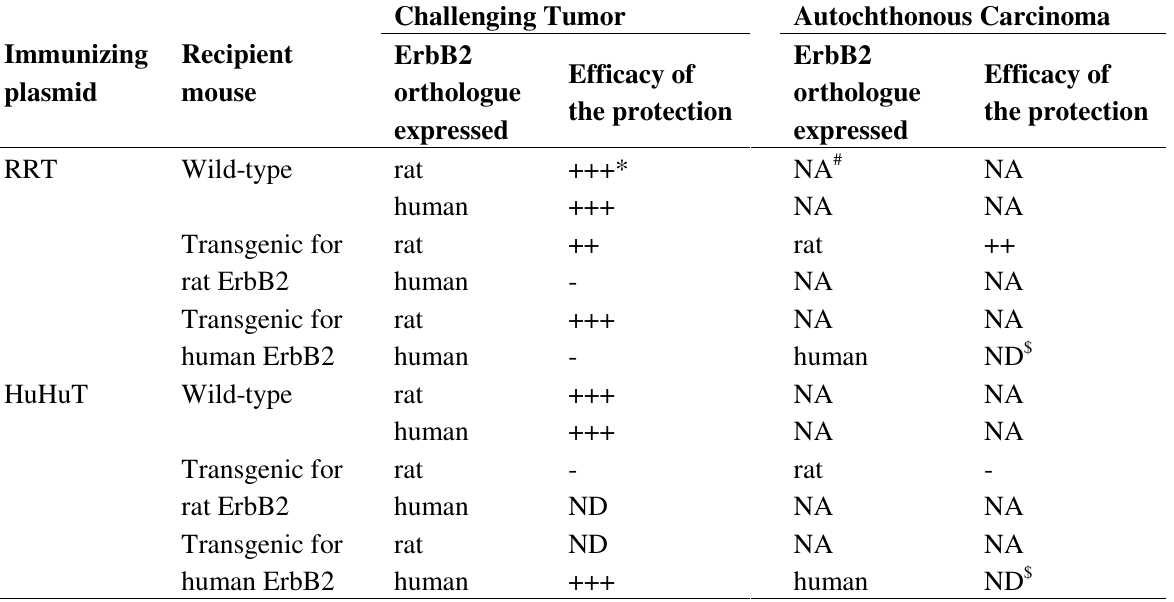
Table 1. ErbB2 orthologue restriction of the protection against tumor growth elicited by anti-ErbB2 DNA